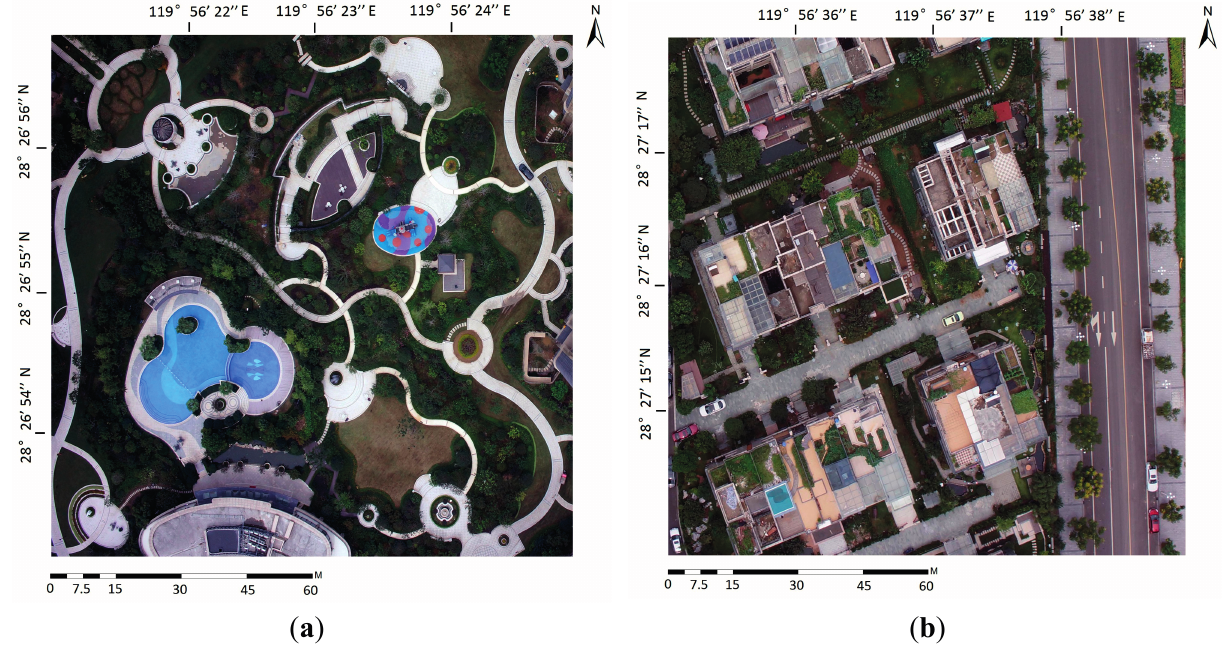
Figure 3. ( a ) A highly-vegetated recreational park; ( b ) A complex residential area.